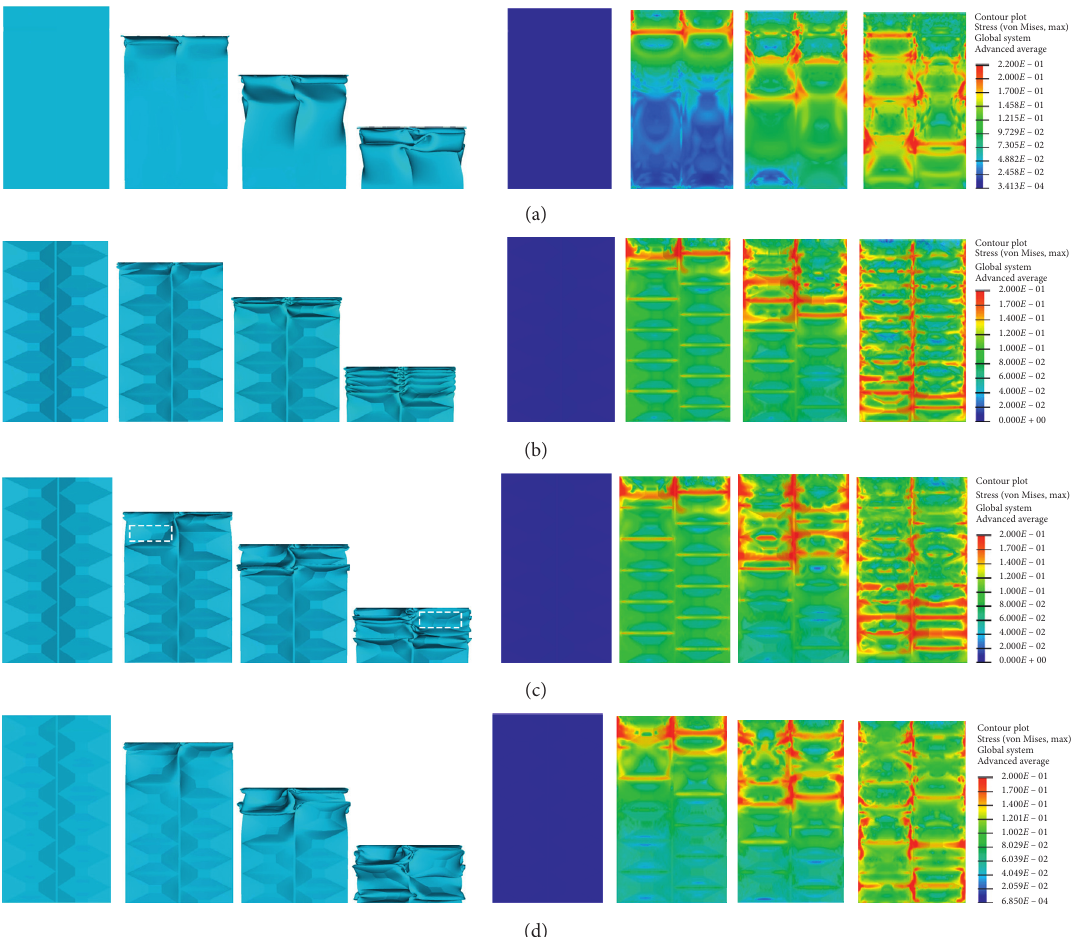
Figure 7: Crushing processes (left) and corresponding von Mises stress contour maps on undeformed patterns (right) of (a) the traditional square tube (SQU), (b) S6_R25_60, (c) S6_R25_68, and (d)